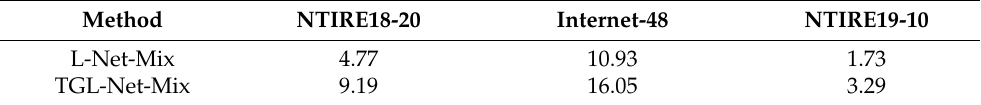
Table 10. Average AG values on three testing